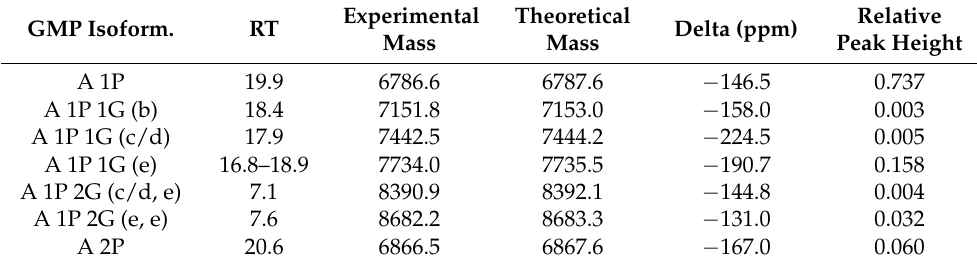
Figure A1. Relationship between the relative abundance of the acidic oligosaccharide 2 Hex 1 NeuAc (6-SL) and N -acetyl- α -neuraminidase activity (r = − 0.27, p -value =0.024). Each native breed is represented by a colour; Western Finncattle (WFC, light red), Norwegian Doela cattle (DOL, green), Eastern Finncattle (EFC, dark blue), Swedish Mountain cattle (SMC, purple), Icelandic cattle (IC, red), native Lithuania Black and White cattle (LT, yellow), Danish Red anno 1970 (RDM-70, light blue) and Norwegian Telemark cattle (TM, orange). Table A1. List of detected glycomacropeptide (GMP) isoforms from Norwegian Doela cattle (individ- ual number 3), to illustrate the isoform composition in a cow of genotype AA. Including retention time (RT), experimental masses, theoretical masses, delta (ppm) and peak heights relative to the total peak heights.